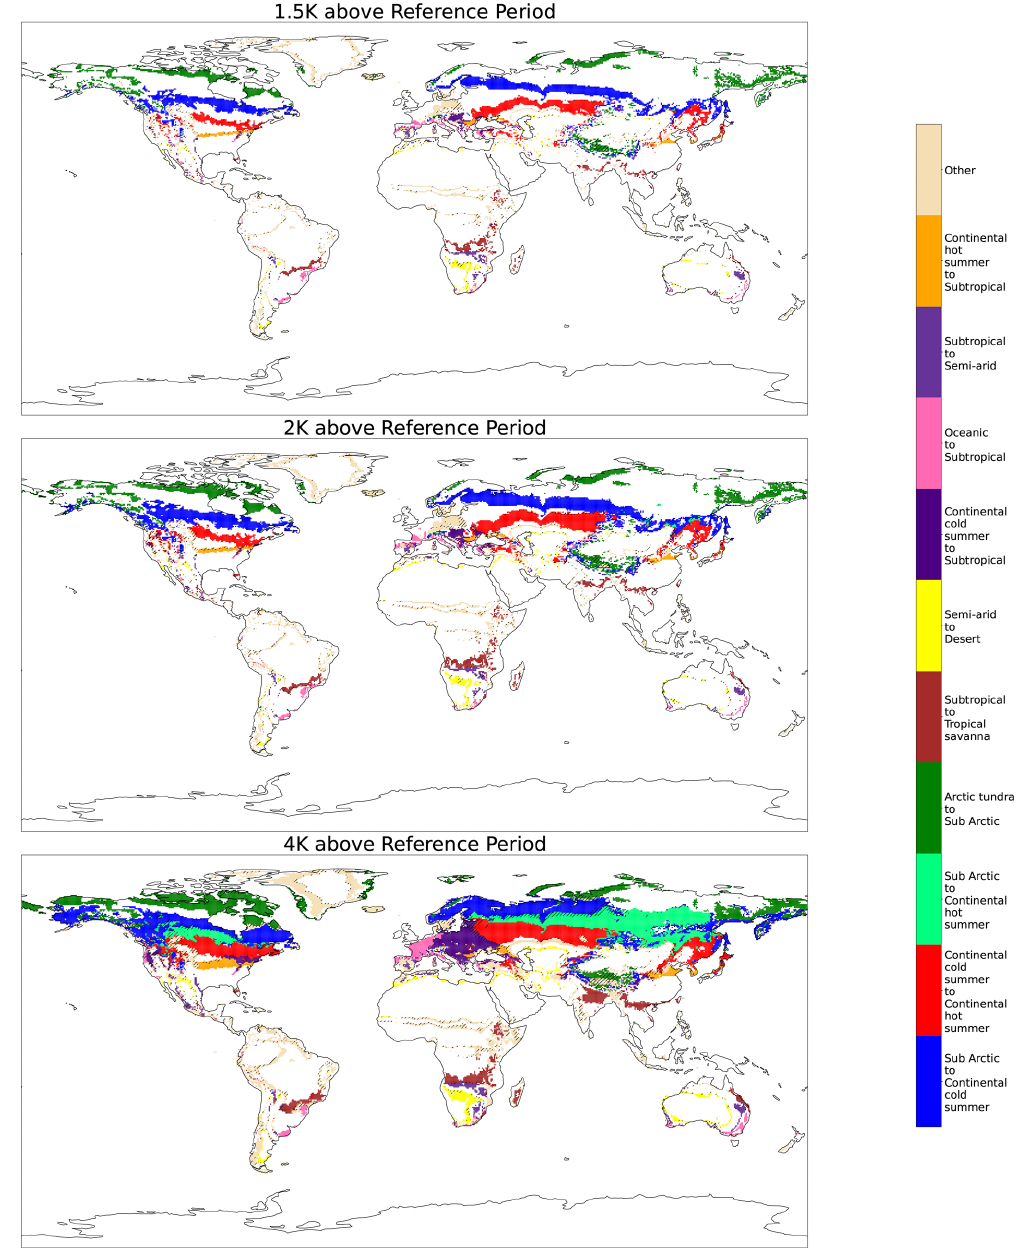
Figure 4. Multi-model ensemble mean difference maps highlighting the 10 largest classification changes for 4K of warming above the refer- ence period using the streamlined classification system. Hatching is present when less than 66% of models agree on a region’s classification